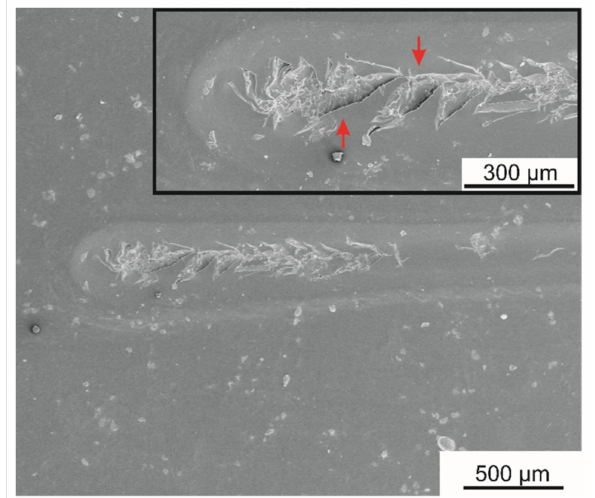
Figure 14. Scratch tracks in the n-HA/ZnS/S-PEEK coating in the places where the characteristic forms of failure occurred; cohesive cracks were marked with